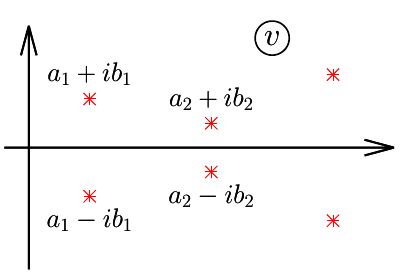
Figure 6 . Singularities of solitons in the complex v